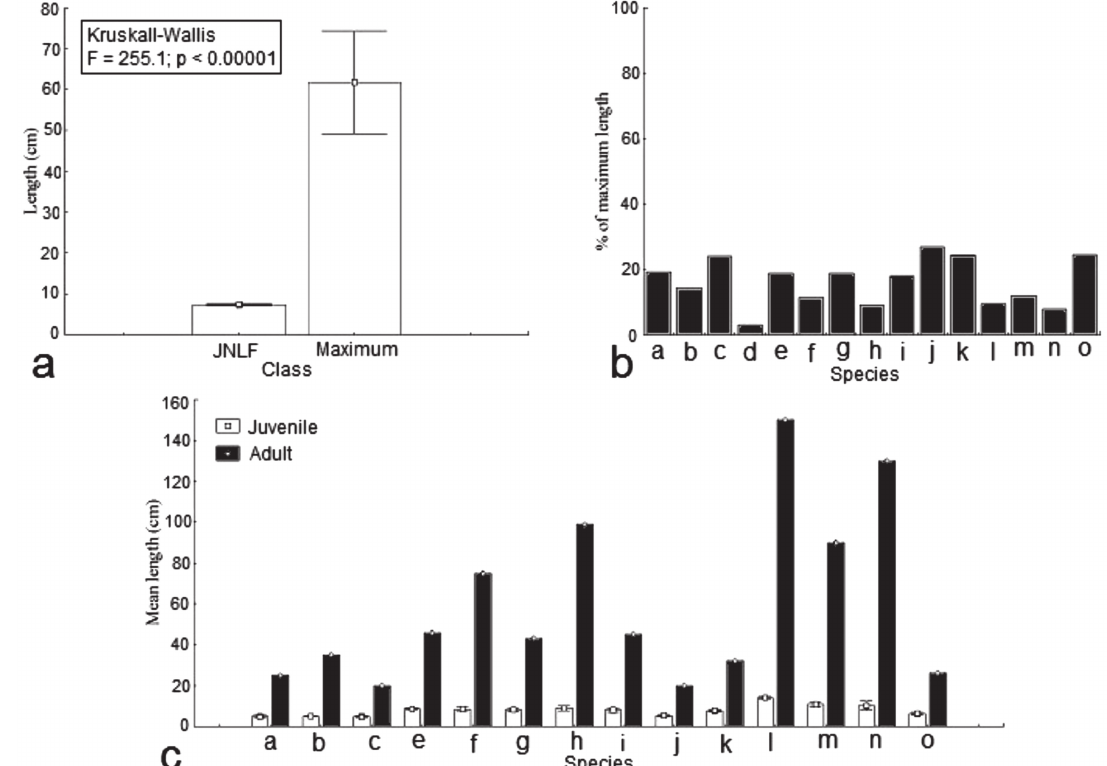
Fig. 4. Length data of non-native large fish, considering the top 15 species available among hobbyists in the unregulated market. a. Mean length of 768 juvenile specimens (± 95% CI) and mean maximum lengths of available species (tested through non-parametric Kruskall-Wallis); b. Sizes of available fishes as percentage of their maximum lengths; c. Mean length of species available in the market and their respective maximum lengths. Species codes: a = Amphilophus citrinellus × Vieja melanura ; b = Amphilophus trimaculatus × Amphilophus citrinellus ; c = Herichthys carpintis + Amphilophus citrinellus × Vieja melanura ; d = Arapaima gigas ; e = Astronotus ocellatus ; f = Cichla kelberi ; g = Cichla piquiti ; h = Cichla temensis ; i = Datnioides microlepis ; j = Heros severus ; k = Hoplarchus psittacus ; l = Lepisosteus oculatus ; m = Osteoglossum bicirrhosum ; n = Pangasianodon hypophthalmus ; o = Uaru amphiacanthoides . The species Arapaima gigas was ommited from figure c because of its large size (mean JNLF = 13.6 cm; maximum = 450.0